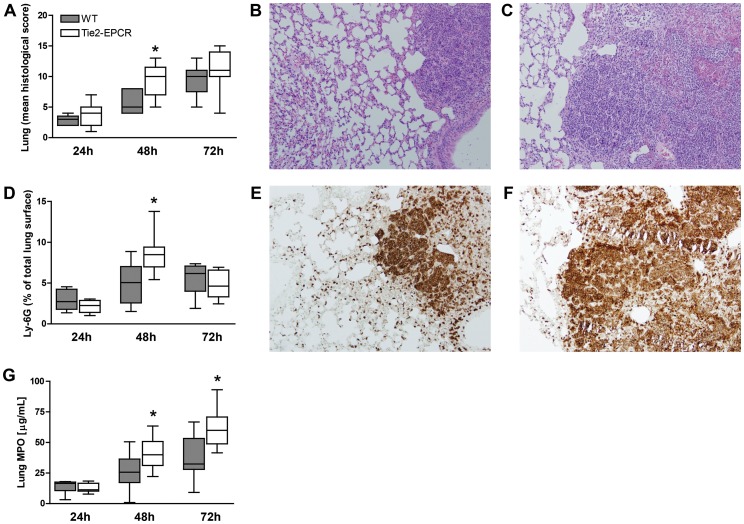
Lung pathology.Fourty-eight hours after infection Tie2-EPCR mice showed increased lung damage compared to WT mice as reflected by increased mean histological scores as described in the Methods section (A). Both WT (B) and Tie2-EPCR (C) mice infected with 300 CFU of B. pseudomallei showed inflammatory infiltrates in the lungs characterized by interstitial inflammation together with necrosis, endothelialitis, bronchitis, edema, thrombi and pleuritis 48 hours after inoculation (H&E staining ×100). Increased granulocyte migration in Tie2-EPCR mice infected with B. pseudomallei was seen 48 hours after infection (D). Representative photographs of Ly-6G-immunostaining (original magnification ×100) for granulocytes of WT (E) and Tie2-EPCR (F) mice showing significantly increased neutrophil influx at 48 h post-inoculation. Tie2-EPCR mice showed increased myeloperoxidase (MPO) levels compared to WT (G) in lung homogenates 48 and 72 h after infection. Data are expressed as box and whisker plots showing the smallest observation, lower quartile, median, upper quartile and largest observation. Numbers of granulocytes are expressed as the percentage of the total lung surface area. Grey boxes represent WT mice, white boxes represent Tie2-EPCR mice (n = 8–9 mice per group for each time point). *P<0.05 and **P<0.01 for WT versus Tie2-EPCR mice (Mann-Whitney U test).